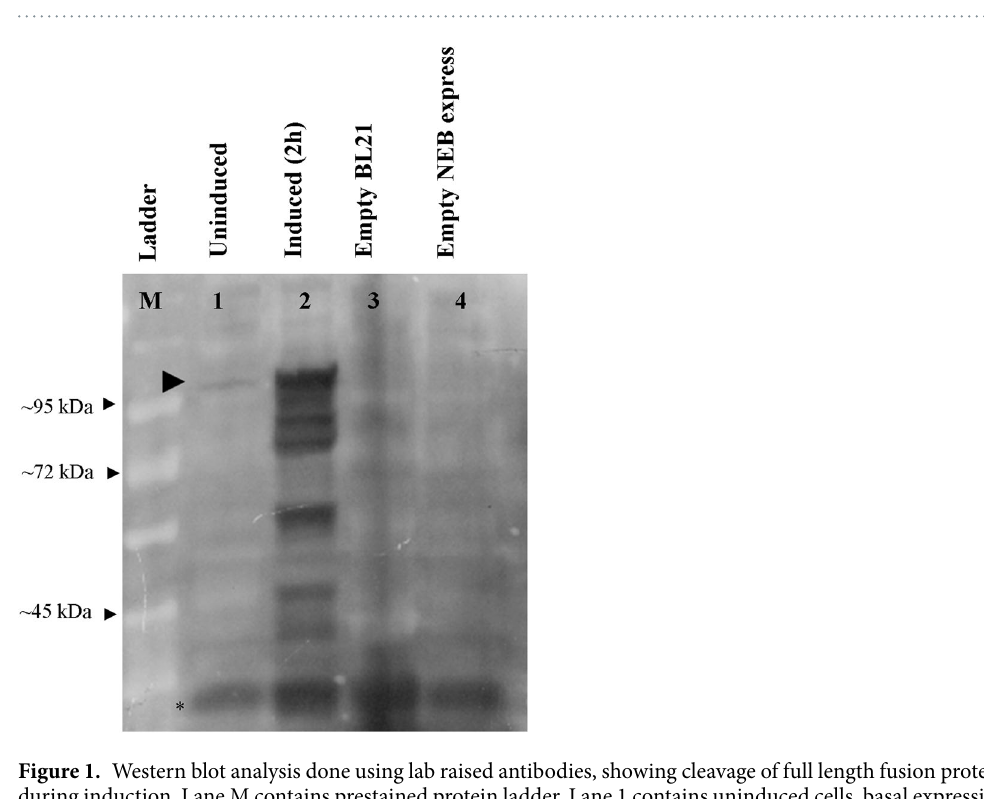
Table 1. Different temperatures used for protein induction and sample collection time at respective temperatures.